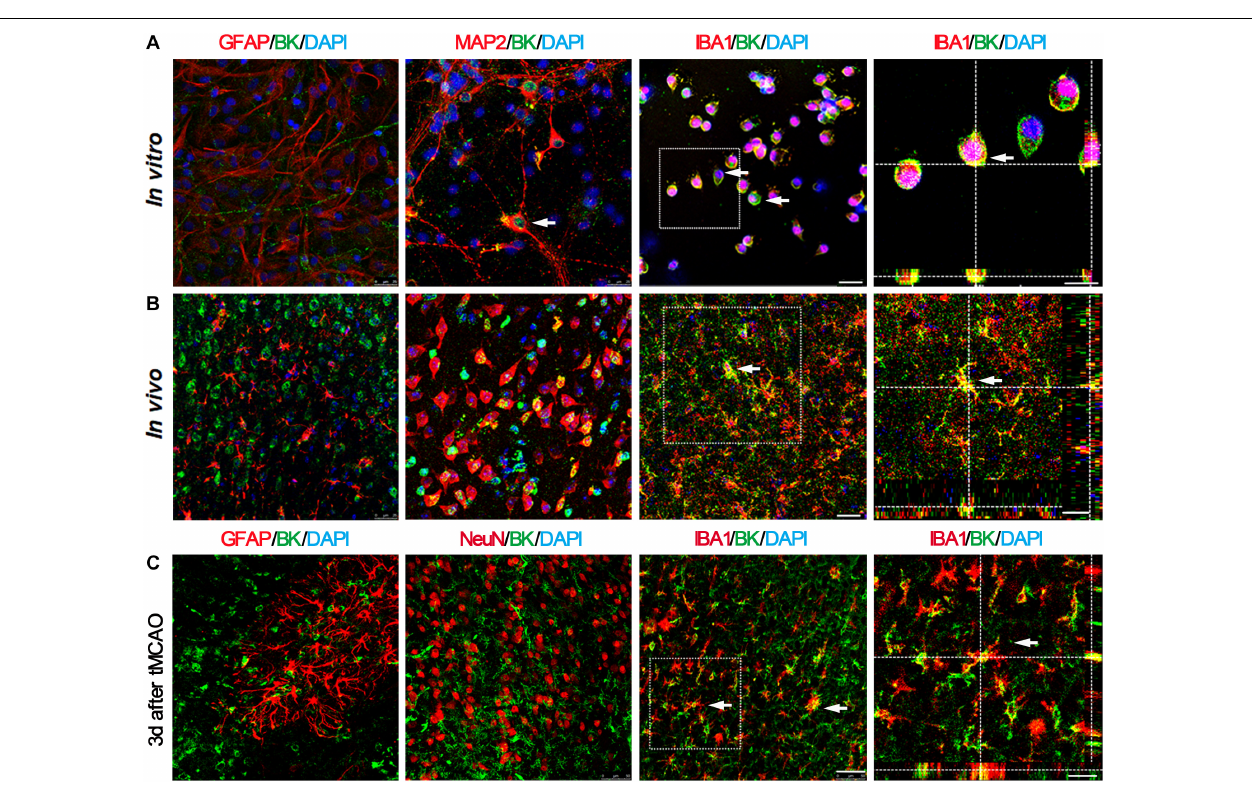
FIGURE 2 | BK channels are mainly expressed in microglia and neurons, but not in astrocytes. (A) Representative photomicrographs show BK (green), GFAP (red), MAP2 (red), and IBA1 (red) double staining in primary cultured cells. Scale bar = 25 µ m. Right-side image indicates that BK is expressed in the IBA1 + microglia by 3D two-photo microscope image. Scale bar = 10 µ m. (B) Representative photomicrographs show BK (green), GFAP (red), MAP2 (red), and IBA1 (red) double staining in the cortex of the normal mouse brain. Scale bar = 25 µ m. Right-side image indicates that BK was expressed within the IBA1 + microglia, scale bar = 30 µ m. (C) Representative photomicrographs of BK/GFAP, BK/NeuN, and BK/IBA1 double staining at 3 days after tMCAO. Scale bar = 50 µ m. Right-side image indicated that BK was expressed in the IBA1 + microglia by 3D two-photo microscope image. Scale bar = 20 µ m.